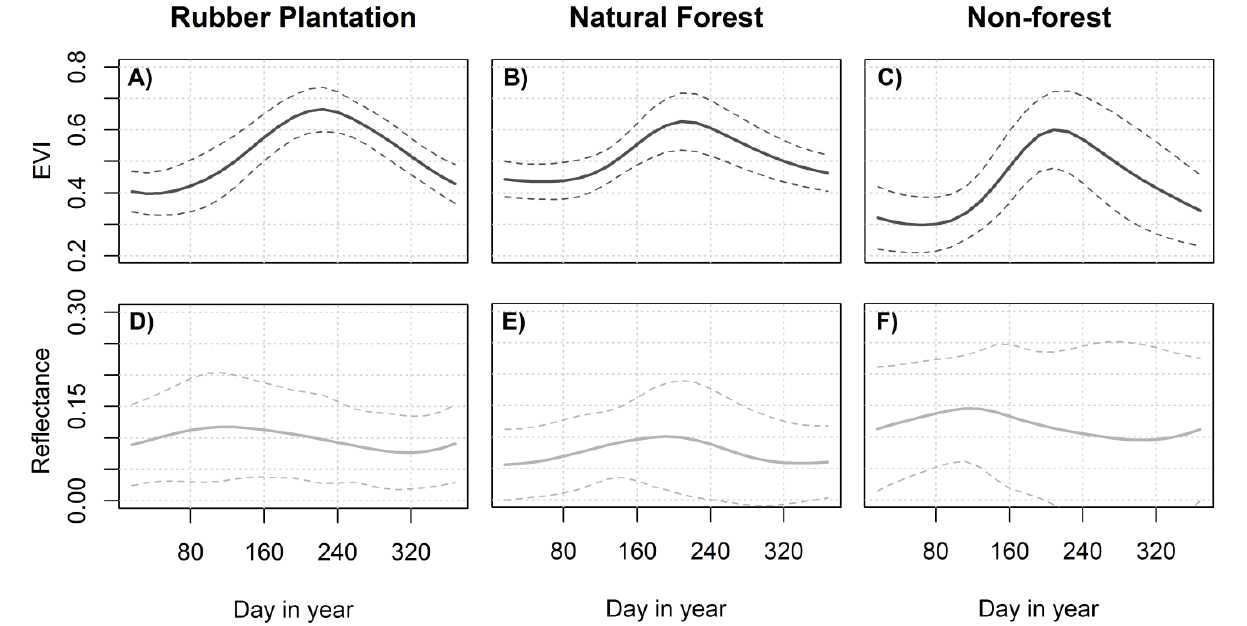
Figure 6. Smoothed Enhanced Vegetation Index (EVI) ( A – C ) and short-wave infrared (SWIR) ( D – F ) time series extracted and averaged for all reference pixels of the rubber plantation, forest, and non-forest classes. Dotted lines indicate one standard